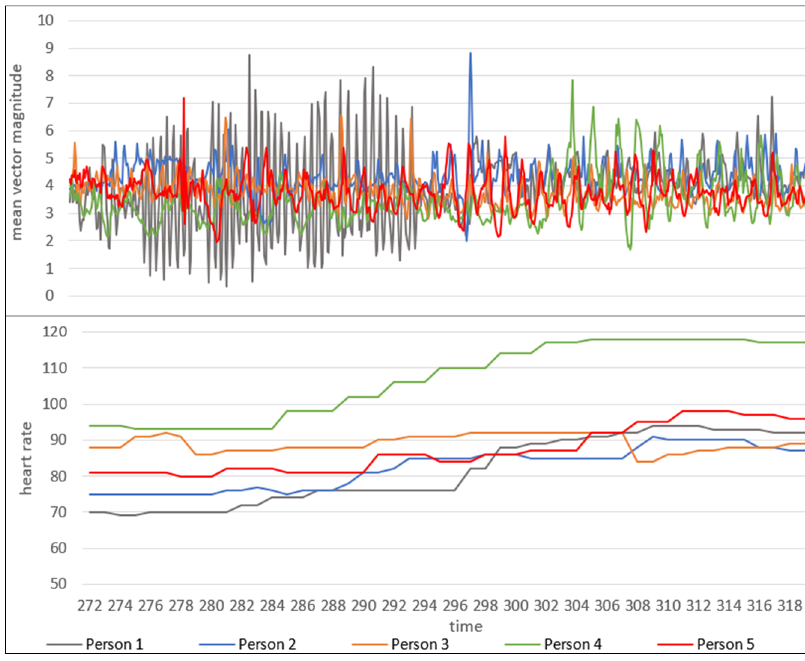
Figure 8. Heart rate and acceleration for the movements pattern.